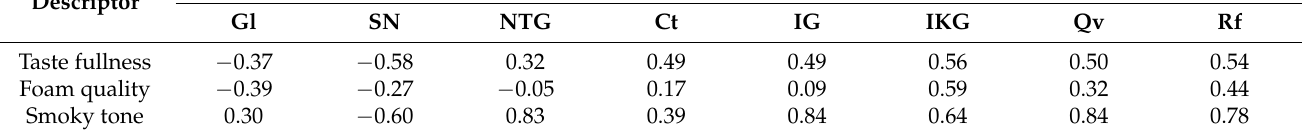
Table 12. Pairwise correlation coefficients of different organic compounds of beer samples (reliability limit p <